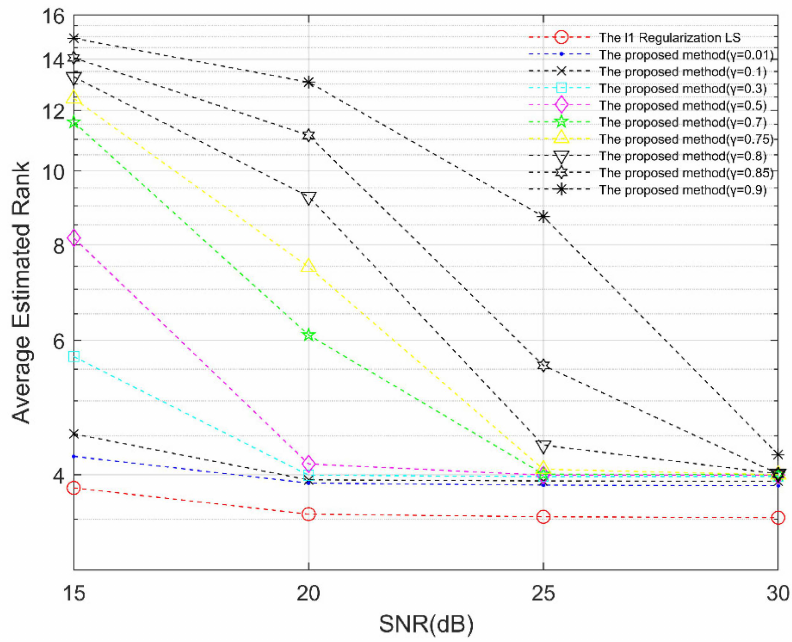
Figure 3. Comparison of the rank estimation performance of the proposed method as a function of γ and the l 1 regularization LS versus SNR with λ = 10 − 4 and real rank R =